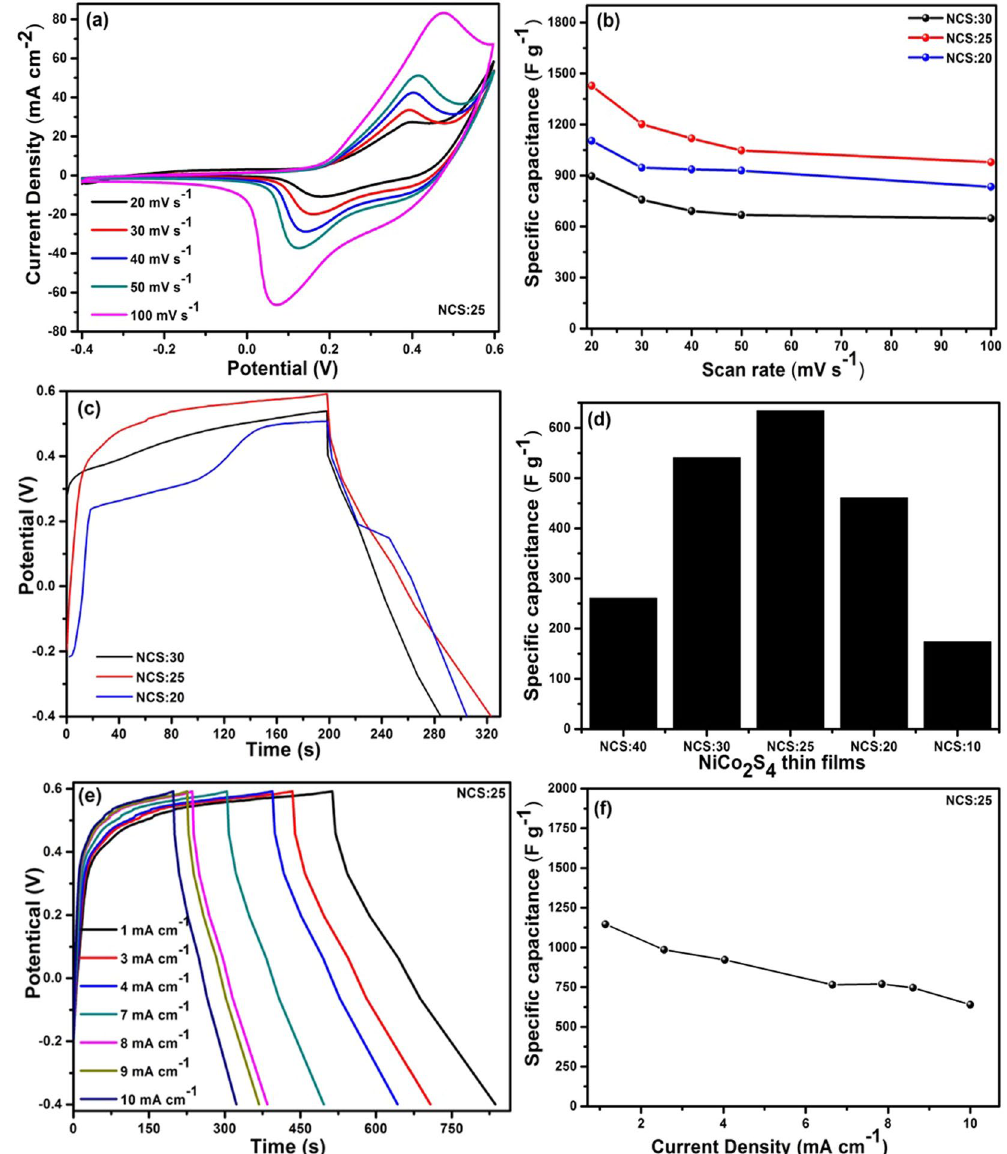
Figure 5. ( a ) CV curves for the optimized NiCo 2 S 4 composite thin films for various Ni and Co ratios (NCS:25) at scan rate from 20 to 100 mV s − 1 with a 5 M KOH electrolyte, ( b ) Specific capacitance of NCS:30, NCS:25, and NCS:20 composite thin films, ( c ) Charge-discharge curves for NCS:30, NCS:25, and NCS:20 at 10 mA cm − 2 current density in 5 M KOH with − 0.4 to 0.6 V potential window, ( d ) Specific capacitance for NCS:40, NCS:30, NCS:25, NCS:20 and NCS:10 electrodes, ( e ) Charge-discharge curves for NCS:25 at 1–10 mA cm − 2 current densities in a 5 M KOH electrolyte, ( f ) specific capacitance of NCS:25 electrode at various current densities from 1–10 mA cm − 2